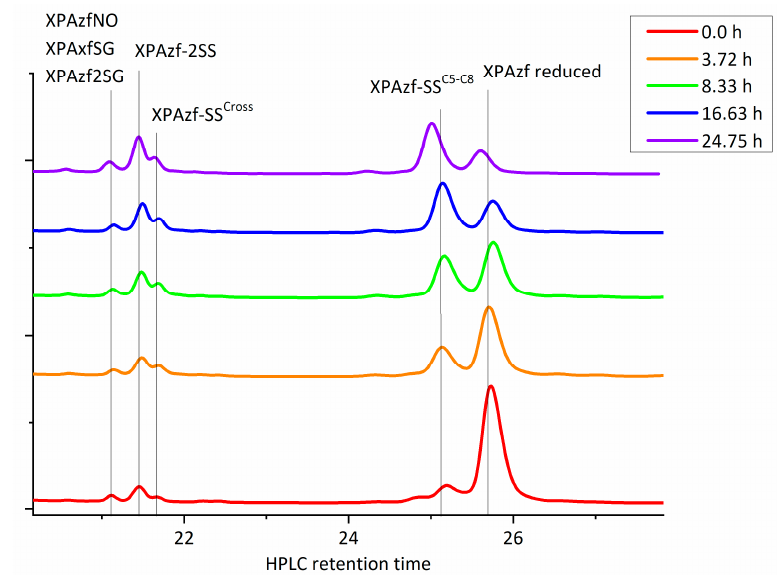
Figure 2. The exemplary set of HPLC chromatograms obtained for the reaction of 10 µ M ZnXPAzf with a three-fold molar excess of S-nitrosoglutathione (GSNO). The times of the reaction [h] and peak assignments are given in the graph. The label SS C5-C8 indicates the presence of C5-C8 disulfide bond, the label SS cross denotes the presence of disulfide bridges involving either C5 or C8 on one side and either C26 or C29 on another. The assignments are based on previous results [12] and the ESI-MS analysis.